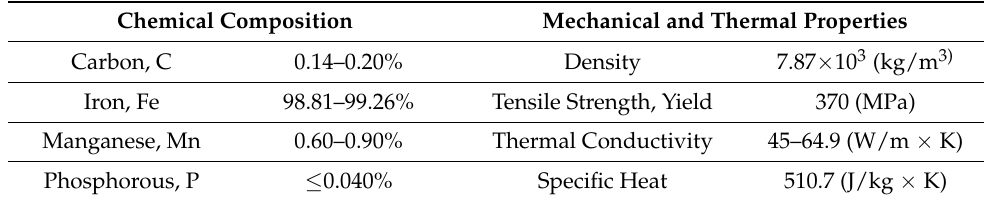
Table 2. The arrangement of depth and size of artificial defects. Table 1. AISI 1018 mild steel mechanical and thermal properties.